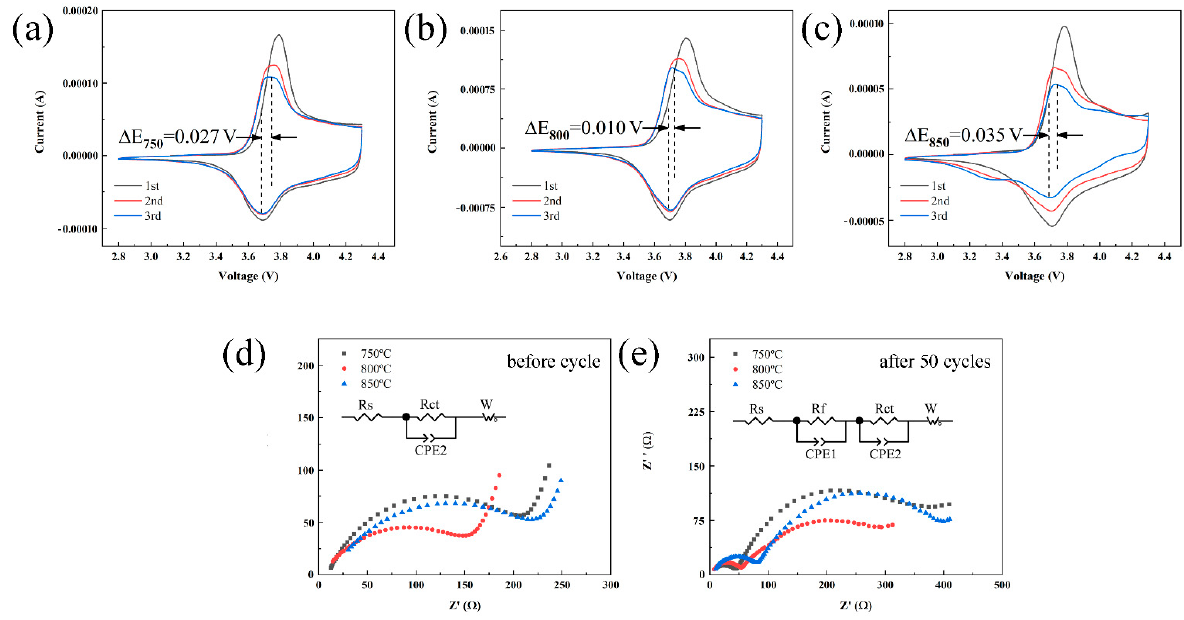
Figure 9. Cyclic voltammetry profiles of ( a ) NCM750, ( b ) NCM800, and ( c ) NCM850 in the 1st to 3rd cycle; Nyquist plots of NCM622 ( d ) before cycling and ( e ) after 50 cycles (the inset shows the equivalent circuit for fitting EIS results). In order to evaluate the electrochemical kinetic performance of the three samples, EIS results for NCM750, NCM800, and NCM850 before cycling and after 50 cycles are shown